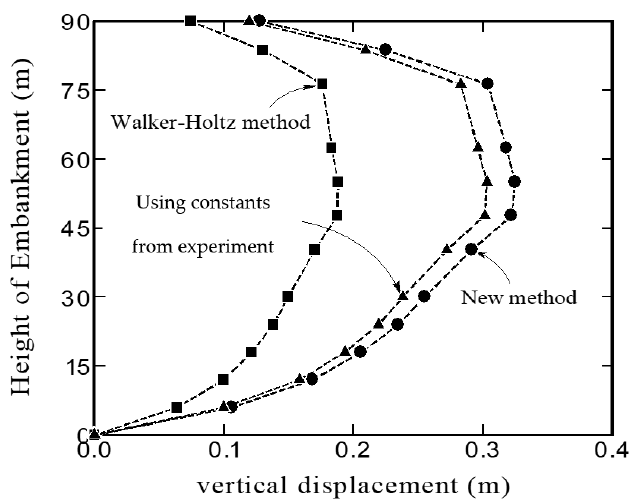
Figure 13. Comparison of the vertical displacement distribution with height at the center of the embankment between three different sets of material constants.